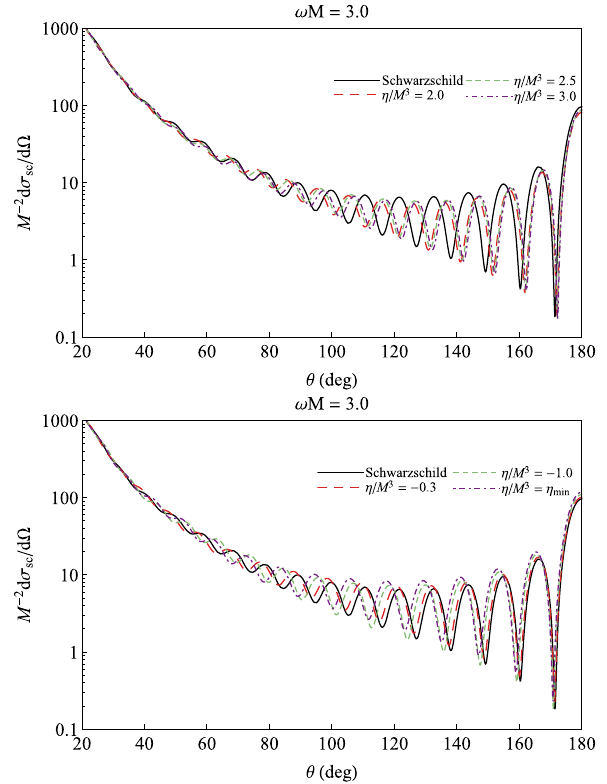
Fig. 5 Differential scattering cross section for some deformed black holes with positive (top panel) and negative (bottom panel) values of the deformation parameter. The Schwarzschild case is also shown, for comparison